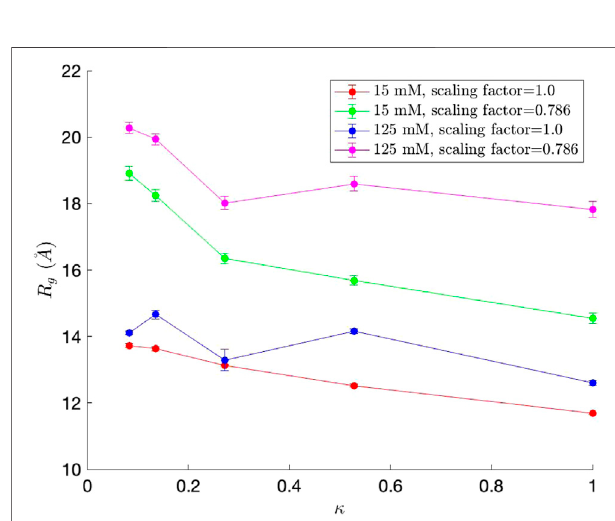
FIGURE 5 | Radius of gyration ( R g ) values for each of the fi ve (Glu-Lys) 25 IDP sequence variants. Since each (Glu-Lys) 25 IDP sequence variant has a different κ value, which represents the measure of charge segregation (Das and Pappu, 2013), κ was used as one of the axes of the graph.